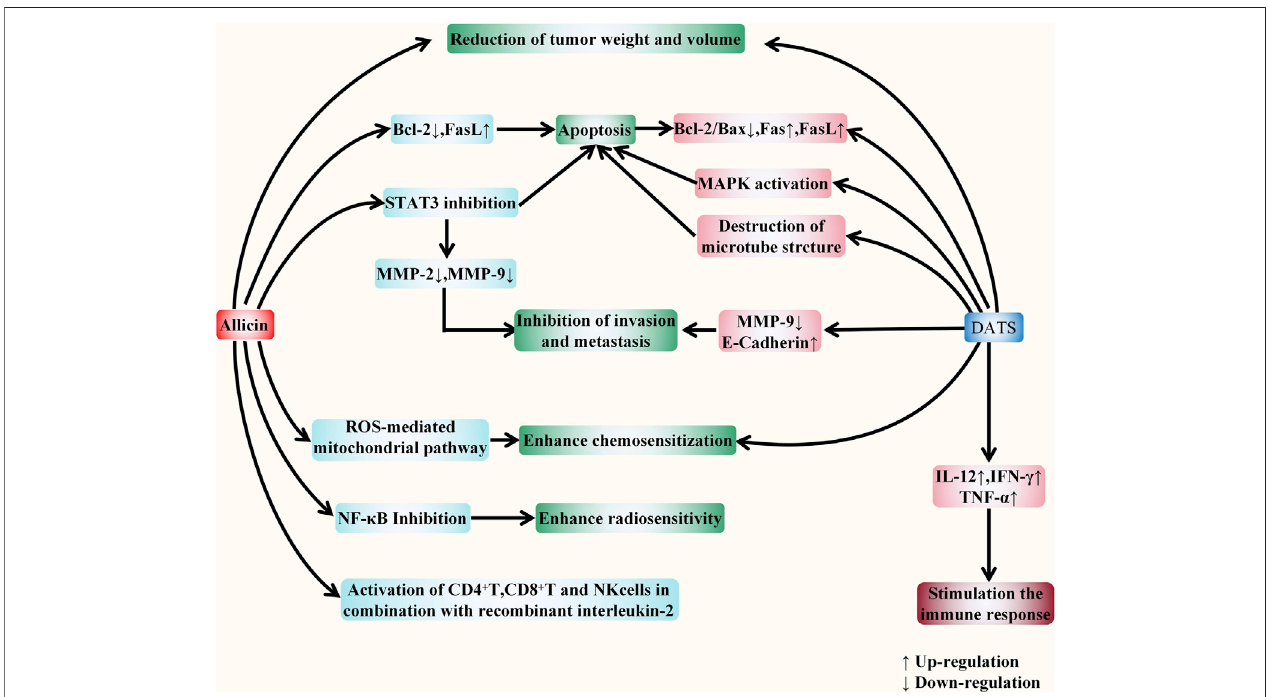
FIGURE7| ThecomparisonbetweentheeffectsofallicinandDATSagainstdigestivesystemcancers invivo .The fi guresummarizesthedifferentanticancereffects of allicin and DATS in vivo . Firstly, allicin and DATS have four consistent anticancer effects, including reducing tumor weight and volume, inducing apoptosis, inhibiting tumorinvasionandmetastasis,andenhancingtumorcellchemosensitivity.Bothcompoundscaninduceapoptosisbyregulatingapoptosis-relatedproteins.Inaddition, allicin can also induce apoptosis, inhibit tumor invasion and metastasis by inhibiting STAT3, and enhance tumor chemosensitivity through ROS-mediated mitochondrialpathway.However,DATSinducesapoptosisbyactivatingMAPKpathwayanddestroyingcellmicrostructure,andinhibitinvasionandmetastasisbydown regulatingMMP-9andupregulatingE-cadherin.Allicinalsohastwomoreeffects:enhancingtheradiotherapysensitivityoftumorcellsandactivatingTcellsandNKcells with the participation of recombinant interleukin-2. DATS has one more effect: increasing the expression of cytokines, including IL-12 and IFN- γ , TNF- α , to stimulate the immune response of the host.